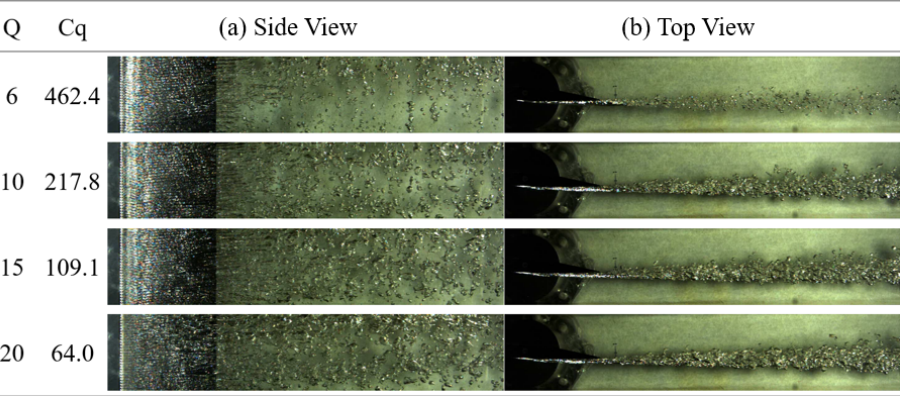
Figure 3. The instantaneous images showing the bubbles at Fn = 50.5 at Q = 6 to 20 SLPM . ( a ) Side view at Q = 10 SLPM . ( b ) Top view at Q = 10 SLPM . (Multimedia view.)